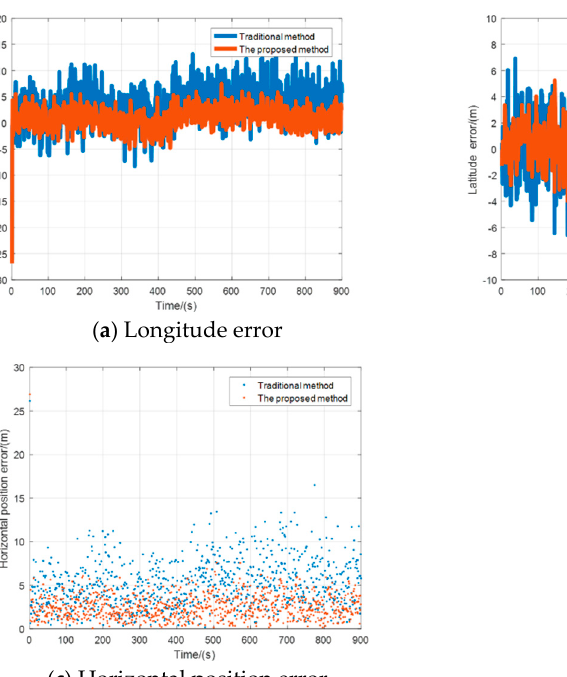
Figure 6. Kinematic test positioning results in an open-sky area.